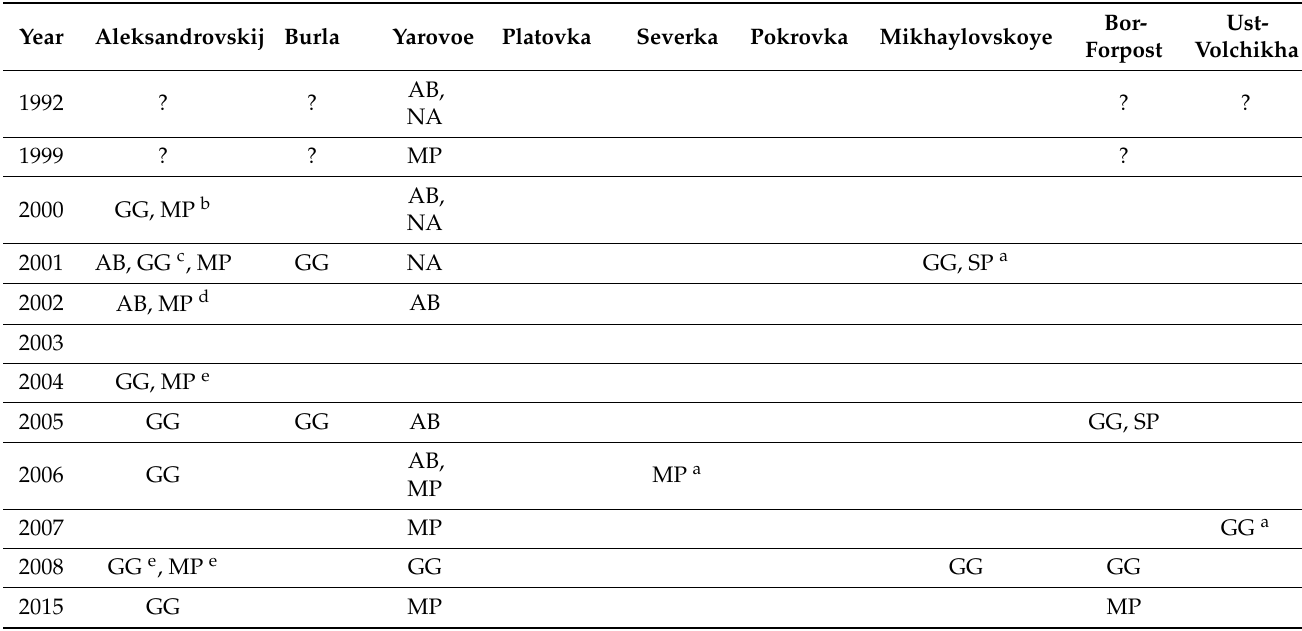
Table 5. Occurrence of rare Orthoptera on sites studied in the Kulunda